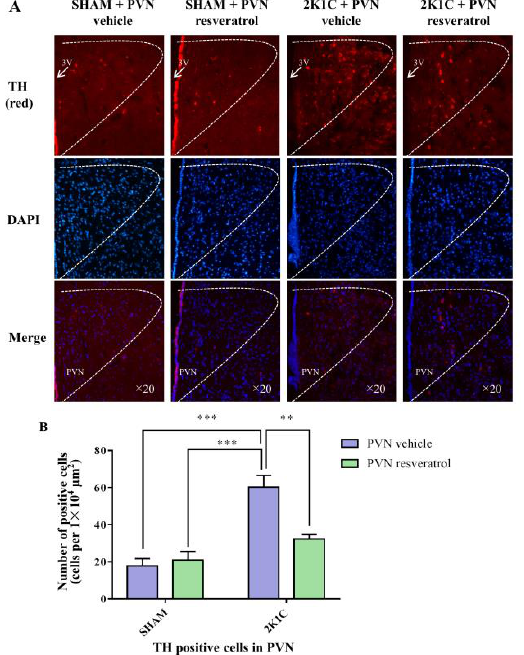
Figure 7. The effects of PVN resveratrol on TH expression. ( A ) Immunofluorescence staining of TH